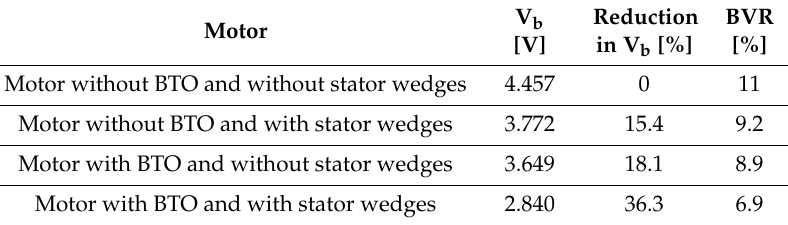
Figure 9. Comparison of the shaft voltage (bearing voltage) of the motor. Red trace is of the motor without the rotor BTO layer and without stator tooth wedges. Yellow trace is of the motor with the rotor BTO layer and stator tooth wedges. Table 4. BVR improvement w.r.t. shaft voltage reduction